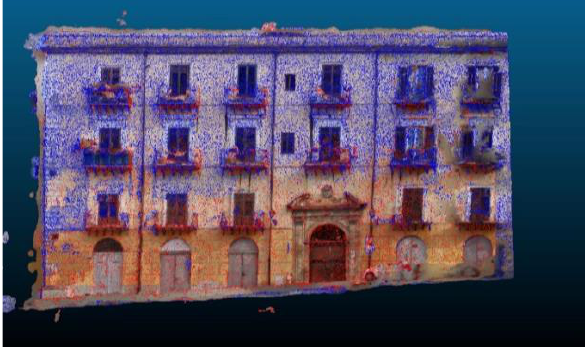
Figure 8: Merge cloud of Low-Image data set dense cloud and ground truth dense cloud. The blue colour indicates a major RMS value than red one.